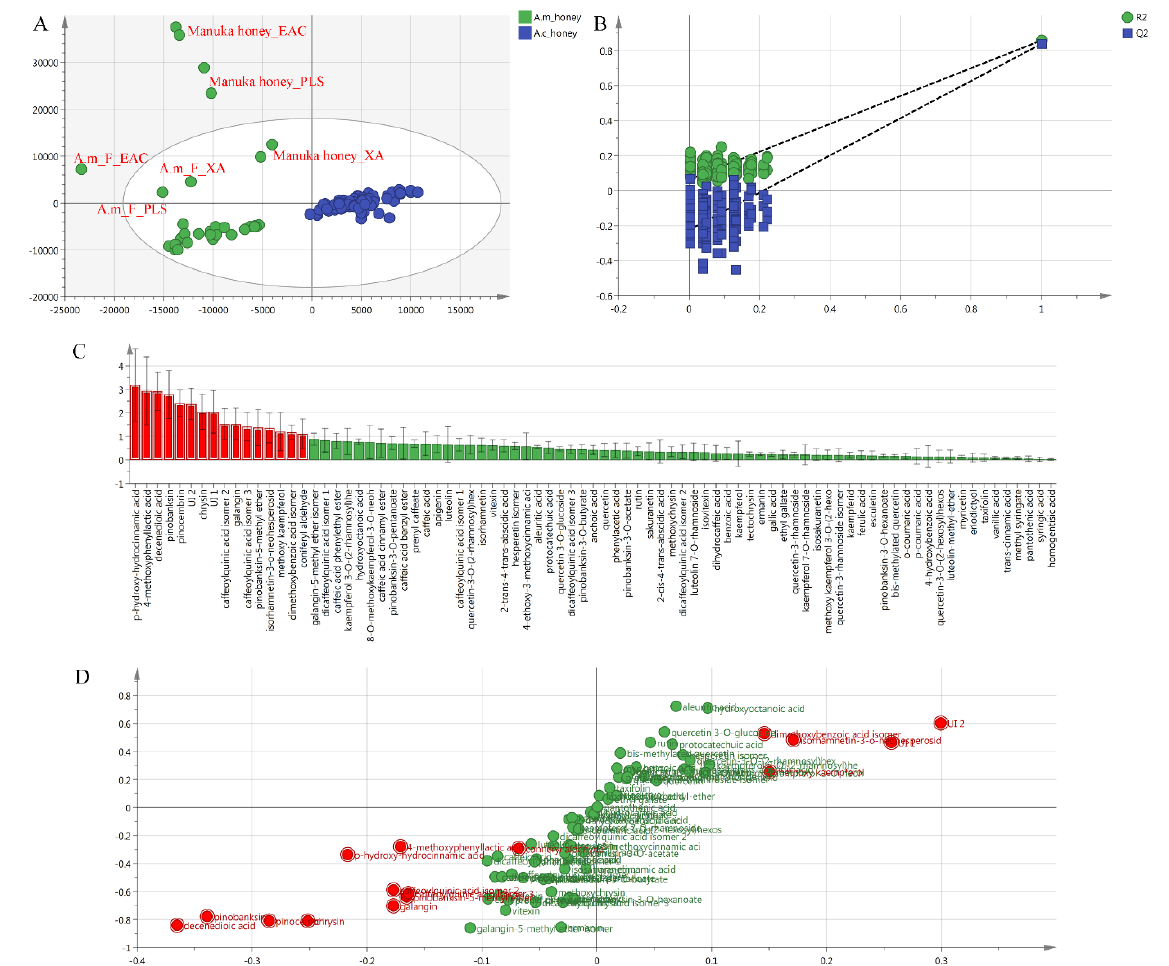
Figure 2. Orthogonal partial least squares-discriminant analysis (OPLS-DA) of A. cerana and A. mellifera honey. Score scattering plot of OPLS-DA ( A ) and corresponding validation plot ( B ); VIP ( C ) and S-plot ( D ) of OPLS-DA.